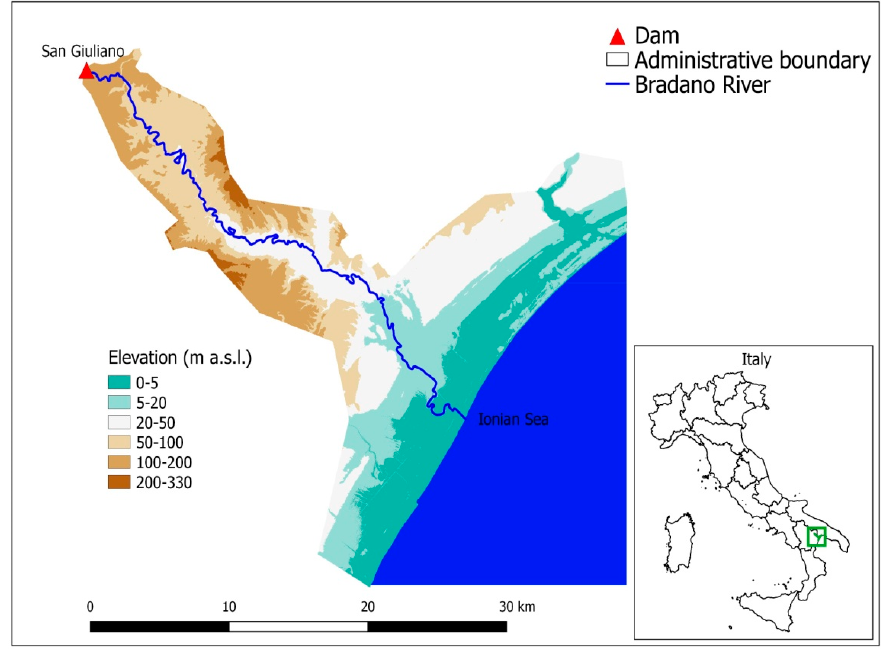
Figure 6. The San Giuliano Dam valley case study.